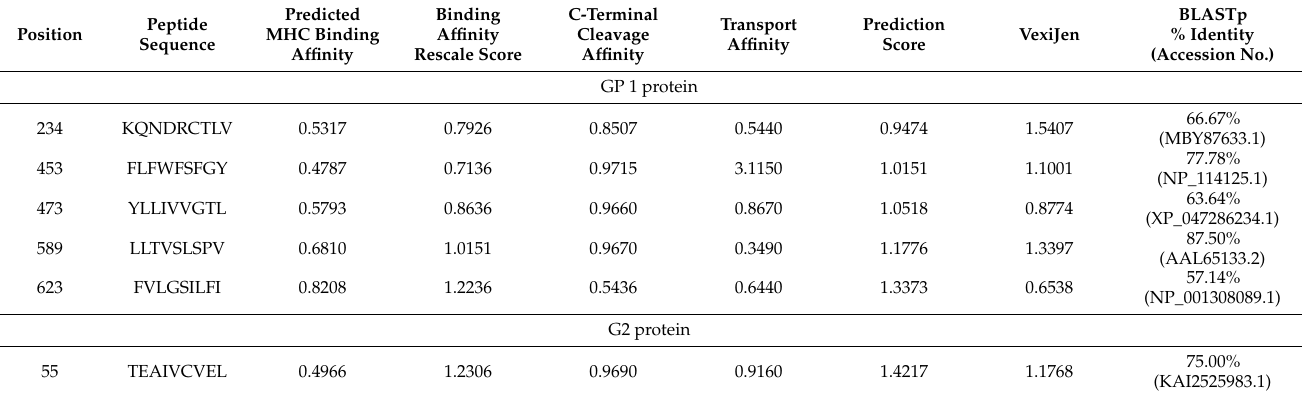
Table 2. Shortlisted CTL epitopes from G1 and G2 of CCHFV. The prediction score threshold was set at >0.75000. Shortlisted epitopes are predicted as non-allergen (AllerTOP v.2.0) and non-toxic